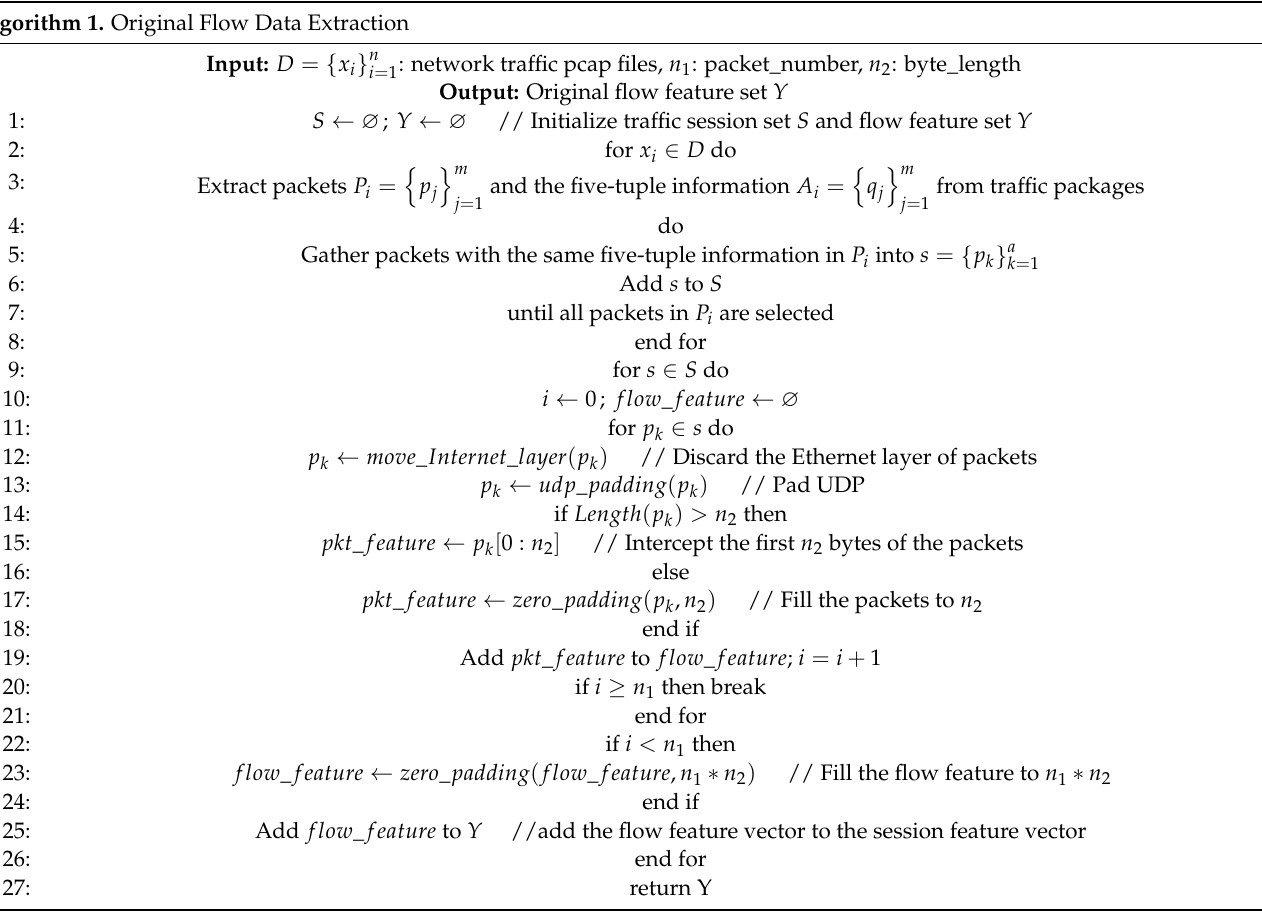
Algorithm 1. Original Flow Data